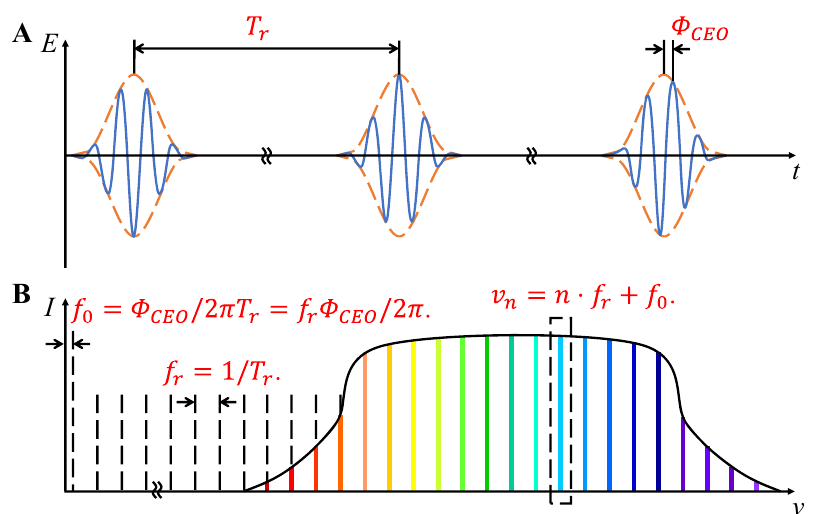
Figure 8: A optical frequency comb based on femtosecond mode-locked laser in the (A) temporal, and (B) frequency domain. Kim et al. [250]. © Optical Society of America